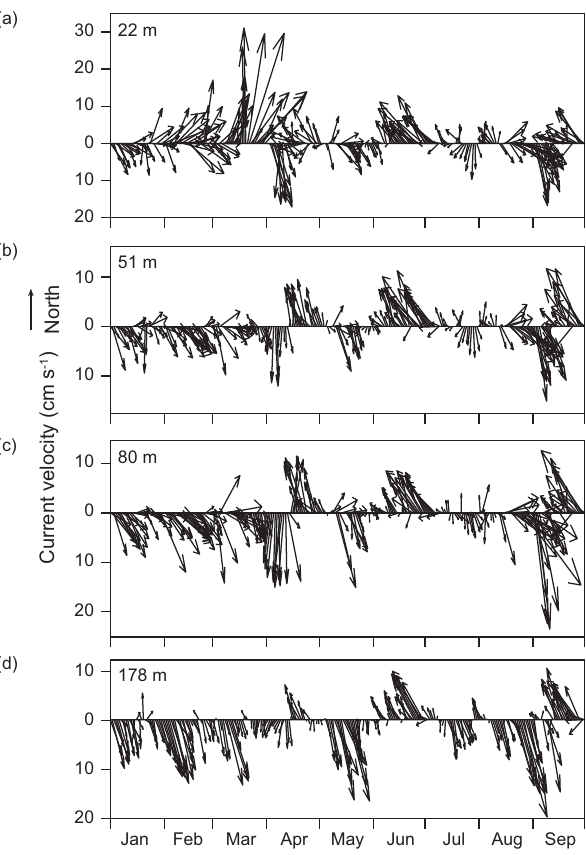
Fig. 5. Time series from January to September 2009 of daily low- pass-filtered current vectors recorded at 22, 51, 80 and 178m depth at mooring CA05. These current vectors aim at presenting the gen- eral seasonality of ocean circulation around the Mackenzie Shelf prior and during the 2009 ArcticNet-Malina field campaign. The location of the mooring is given in Fig. 1 and details of the deploy- ment in Table